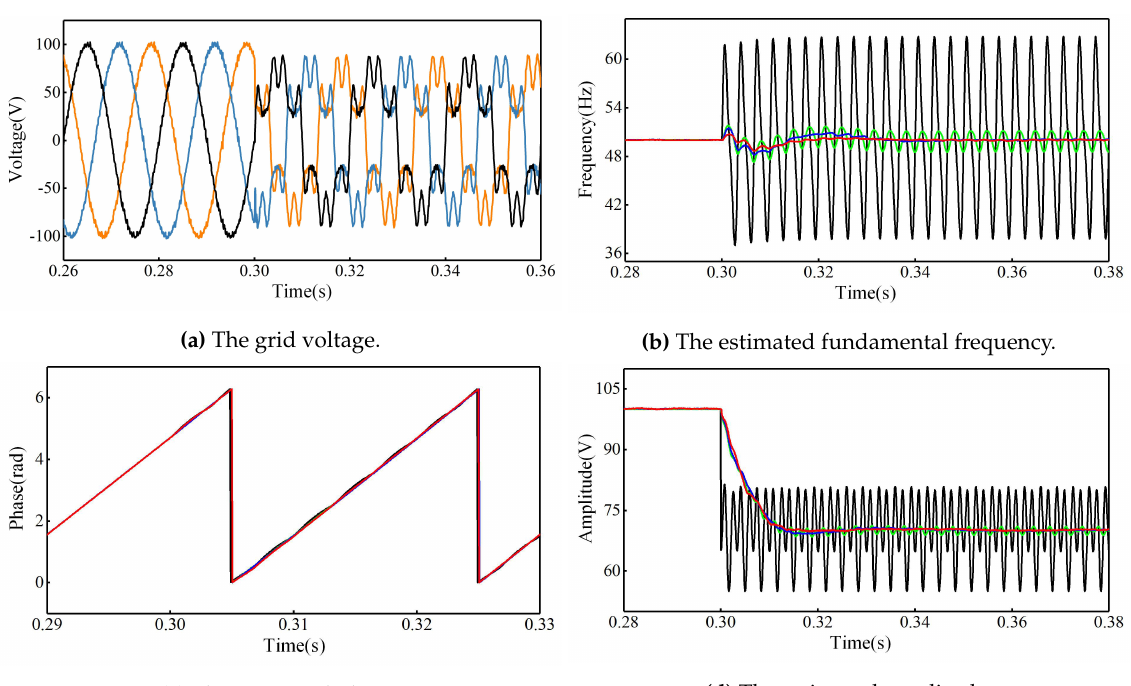
Figure 12. Waveforms of the grid voltage and estimated parameters by SRF-PLL (black line), DDSRF-PLL (green line), MCCF-PLL (blue line) and MDSOGI-IFLL (red